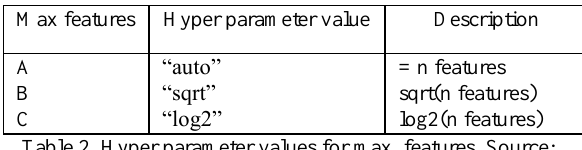
Figure 7. Count of mangroves species